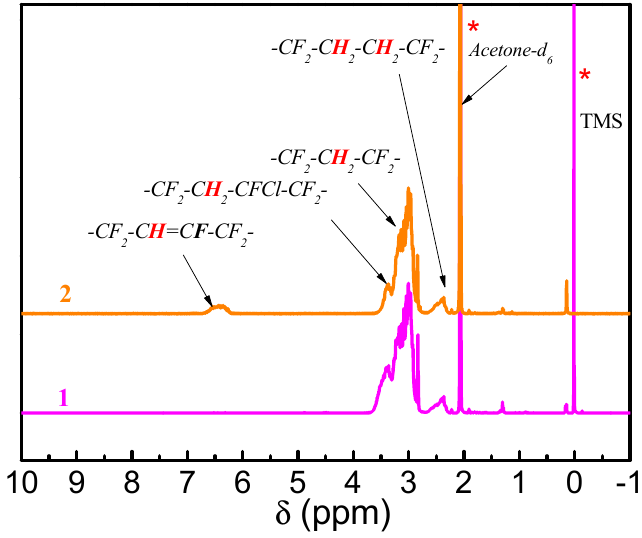
Figure 2. 1 H-NMR spectra of P(VDF-CTFE) (Line 1) and P(VDF-CTFE-DB) (Line 2).